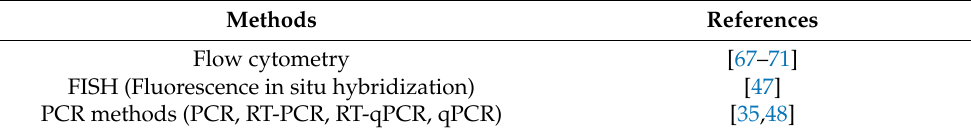
Table 3. Determining the count of probiotic microbes—culture independent methods.